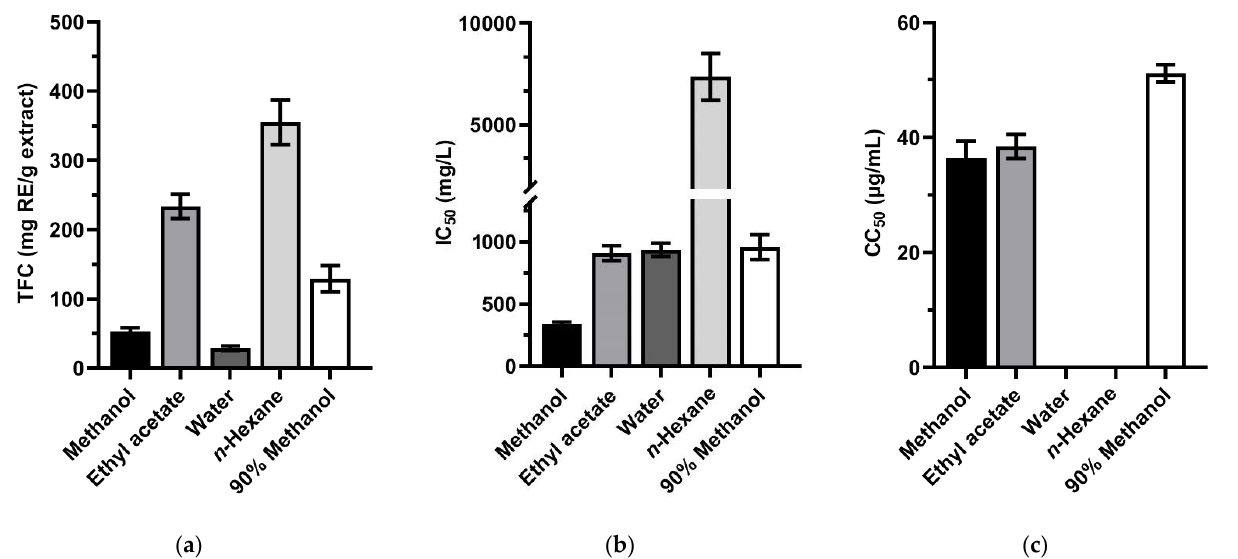
Figure 2. ( a ) Total flavonoids content; ( b ) the antioxidant activity in DPPH assay; ( c ) the cytotoxicity effect on Huh-7 HCC cells of Luvunga scandens leaves extracting in methanol, ethyl acetate, water, n -hexane, and 90% methanol. For panel ( c ), no bar is shown for the extracts that had a 50% cytotoxic concentration of more than 100 µg/mL. Values are presented as mean ± SD ( n = 3). Error bars show standard deviation.